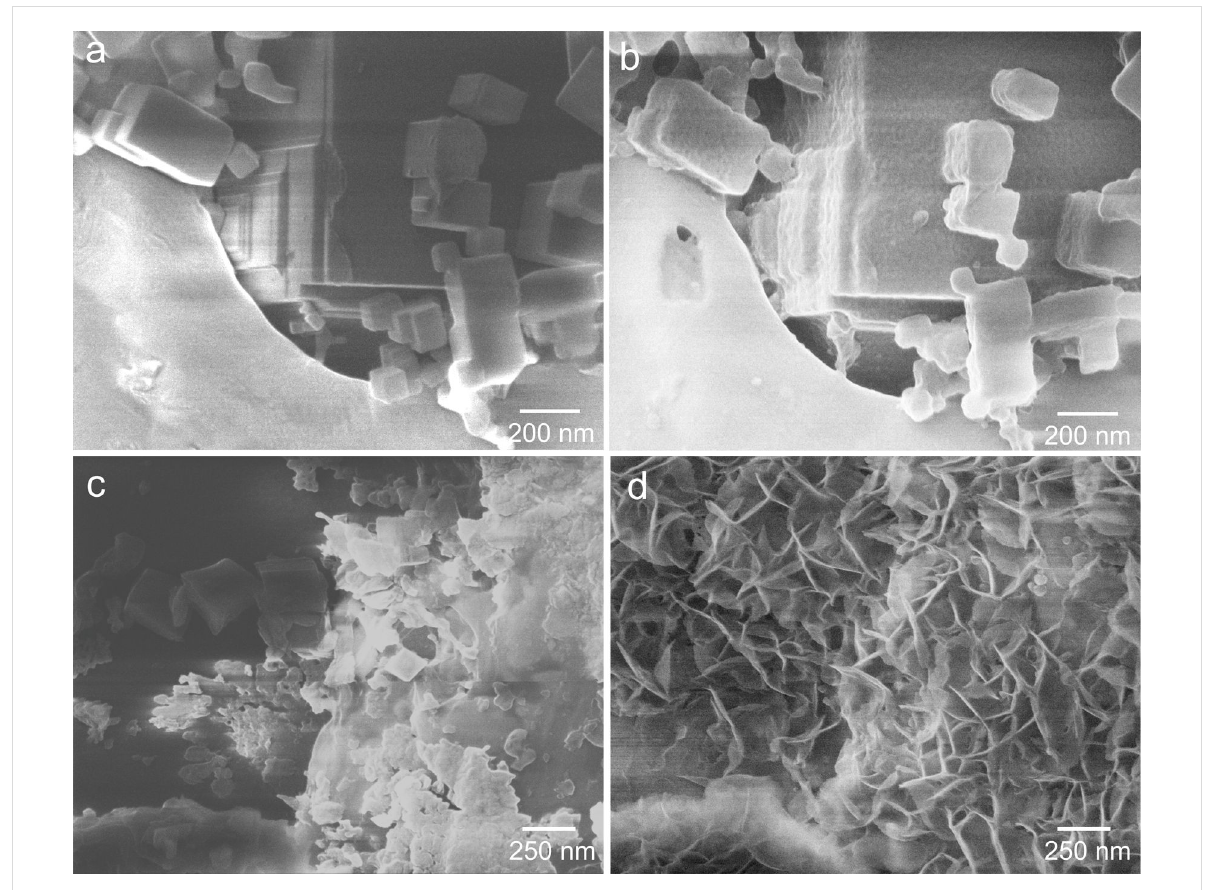
Figure 5: Helium ion microscopy images of vapor-phase-grown MgO cubes before (a,c) and after (b,d) exposure to liquid water. The sample areas imaged in (a) and (c) are the same as the ones imaged in (b) and (d), respectively. Clearly, different types of nanostructures can result from the inter- action of MgO particle surfaces with H 2 O depending on their size and distribution at the sample surface. Comparison between (a) and (b) points to the volume expansion during hydration and hydroxylation, while (c) and (d) show a probable dissolution/precipitation mechanism. (HIM SE images re- corded at 30 kV acceleration voltage and (a,c) 0.3 pA beam current, 1.4·10 15 cm − 2 ion dose, (b,d) 0.1 pA beam current, 1.2·10 15 cm − 2 ion